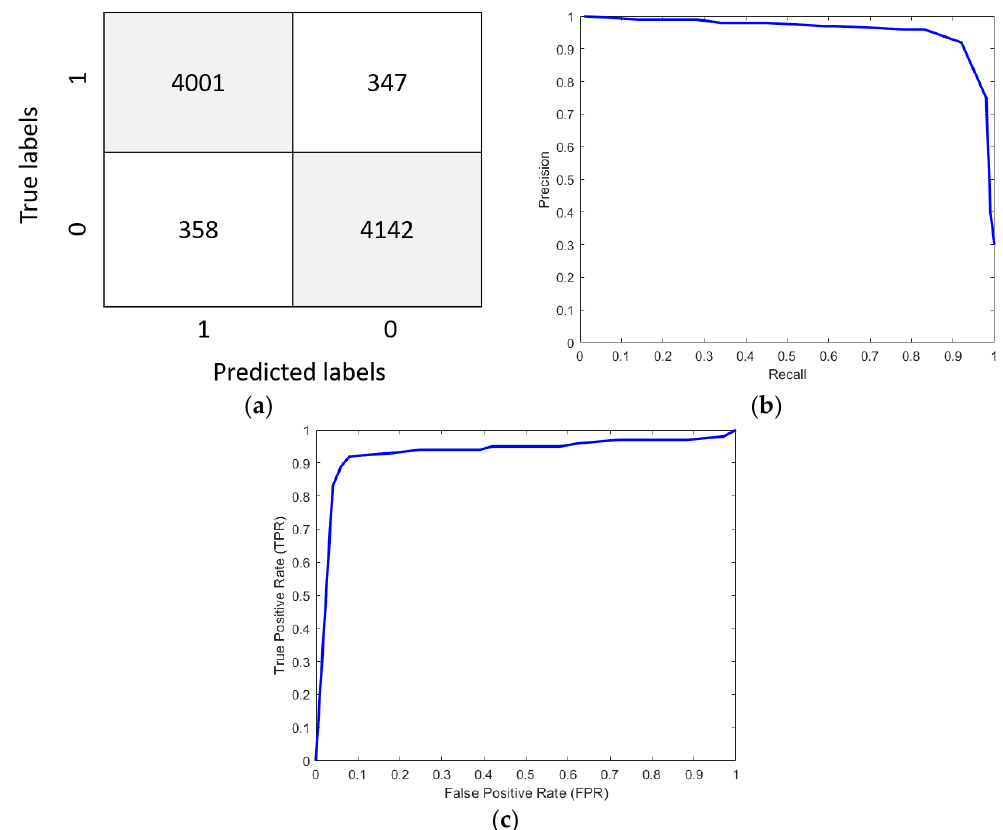
Figure 12. Model evaluation. ( a ) Confusion matrix. ( b ) PR curve. ( c ) ROC curve. Table 2. Influence of different modules in the model.